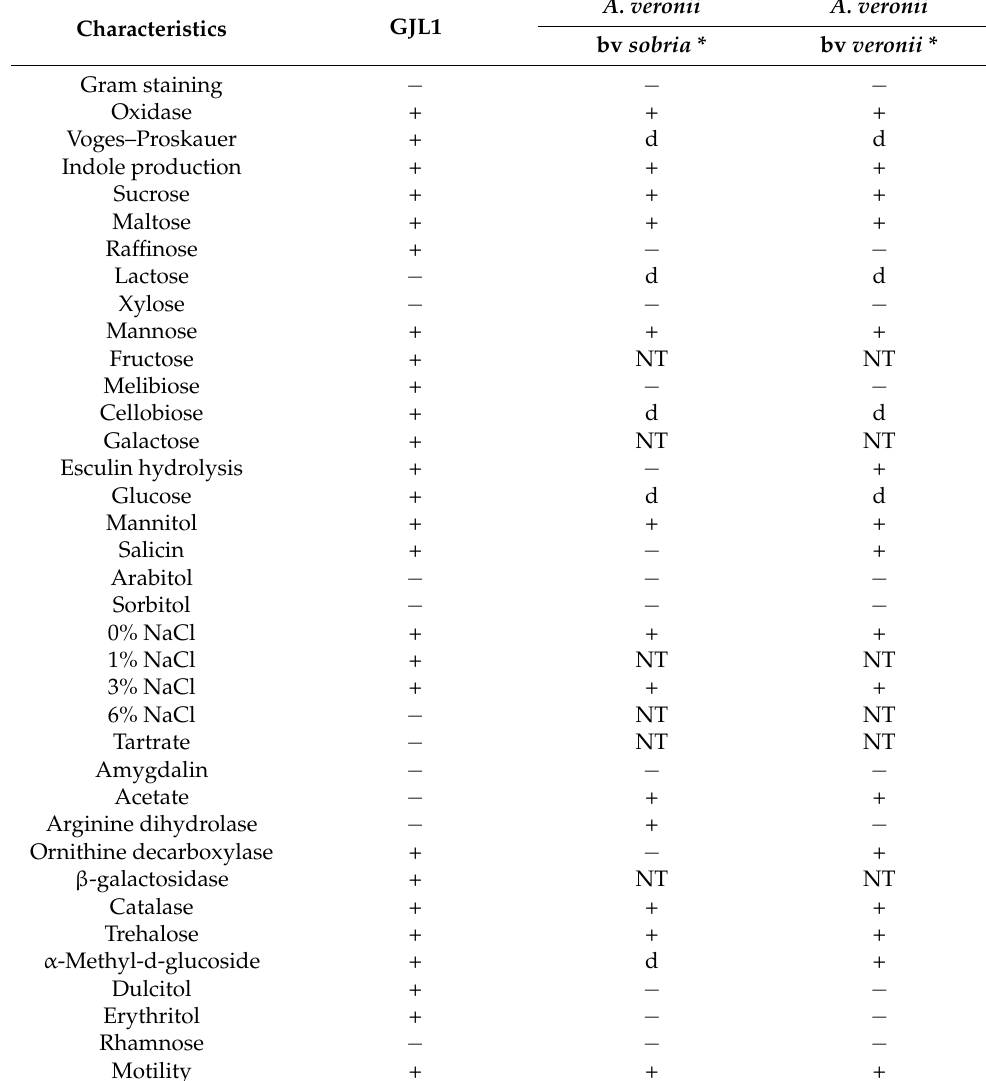
Table 1. Physiological and biochemical characteristics of strain GJL1. Characteristics